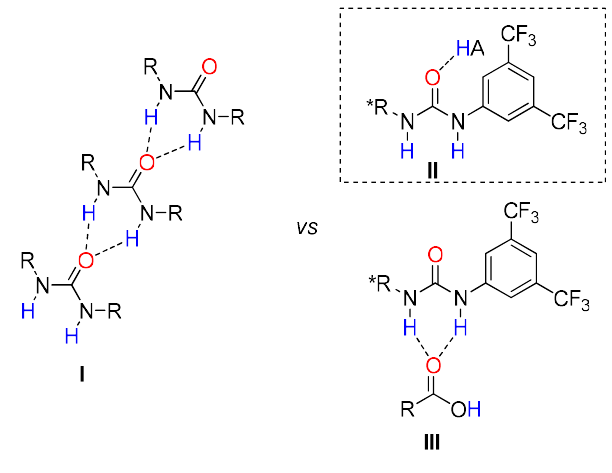
Figure 3. Mechanistic hypothesis.